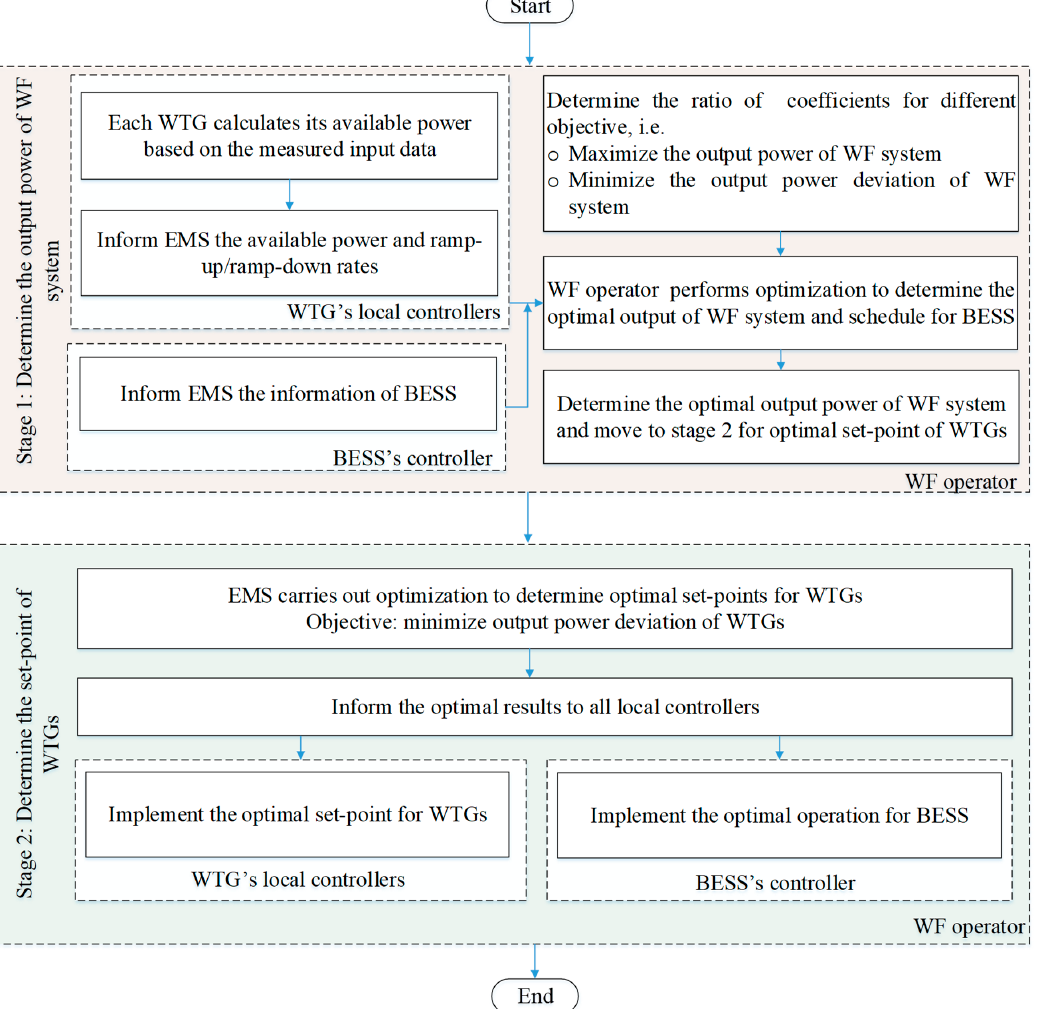
Figure 3. The optimal strategy for the operation of WF system.